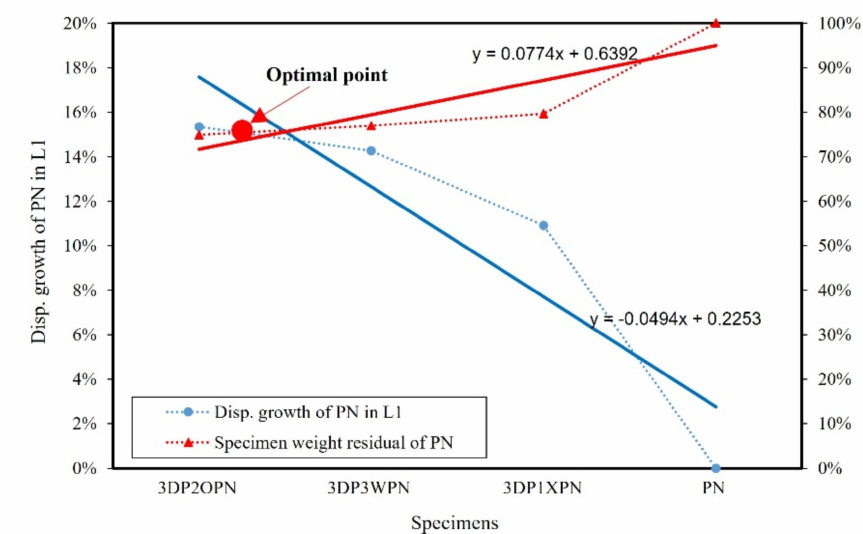
Figure 21. Optimal point of the FEM analysis in loading protocol #1 (L1).